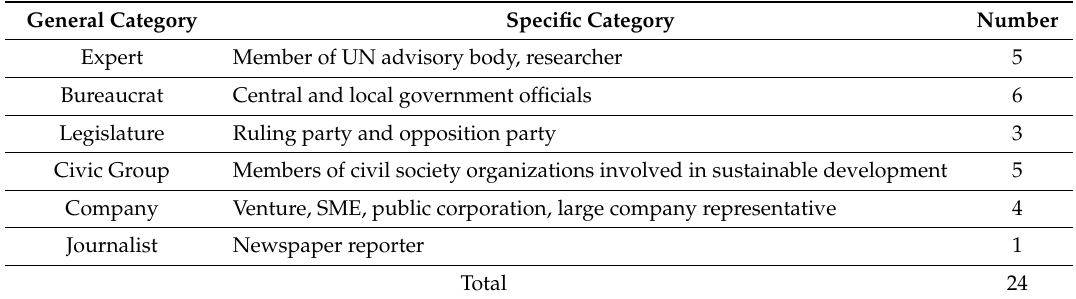
Table 3. Composition of P